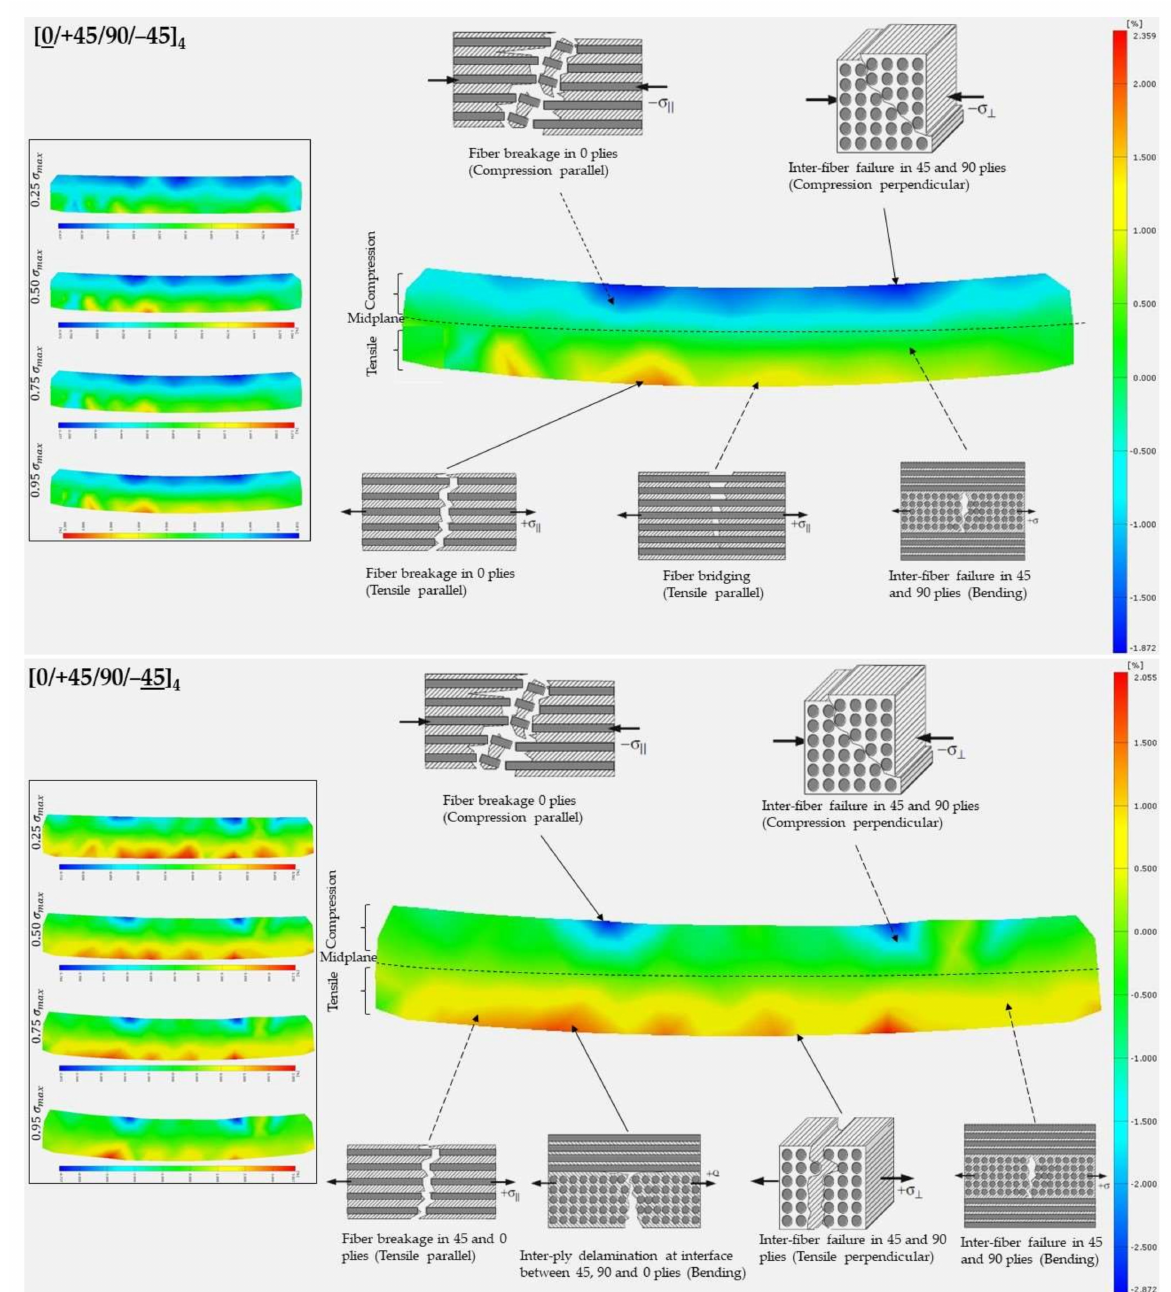
Figure 4. DIC measured ε xx strain at various load levels for ([0/+45/90/ − 45] 4 and [0/+45/90/ − 45] 4 )